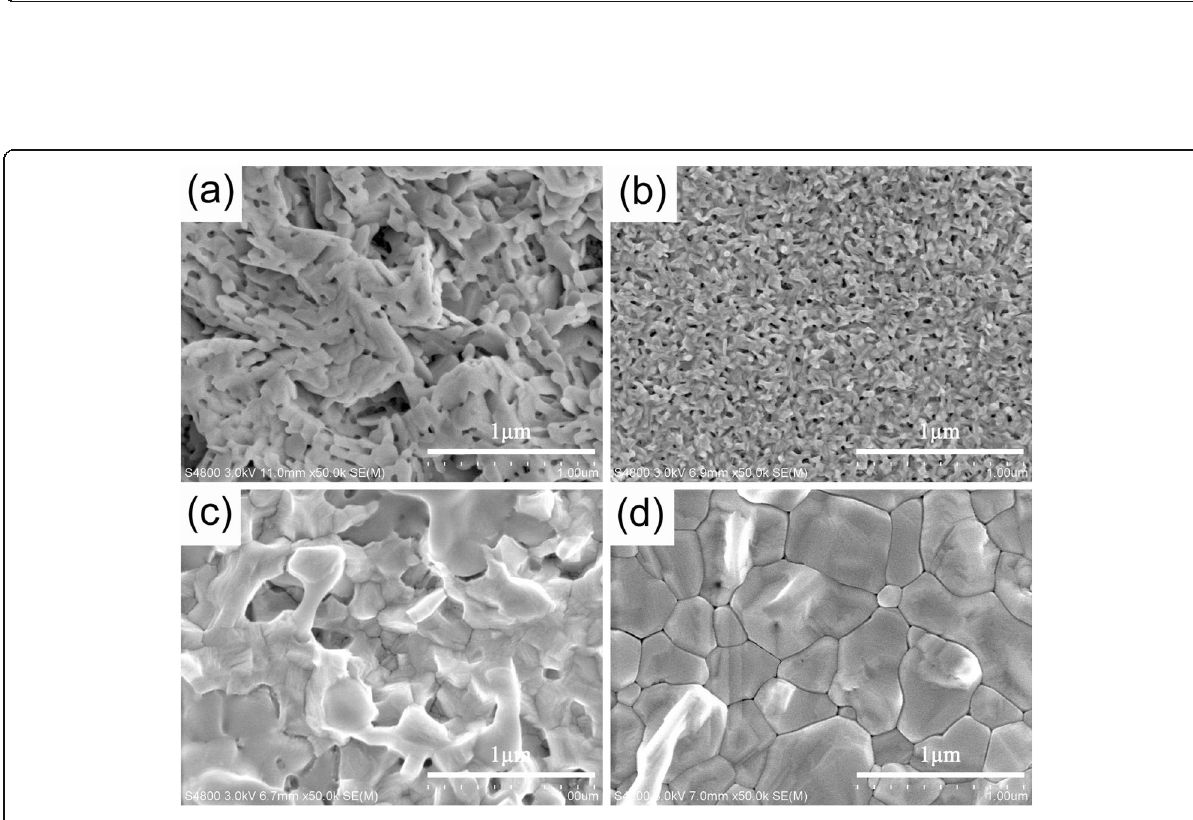
Fig. 3 SEM images of PbI 2 films on FTO/c-TiO 2 /mp-TiO 2 substrates without ( a ) and with ( b ) BTA additive; and corresponding MAPbI 3 films without ( c ) and with ( d ) BTA additive prepared under 25%